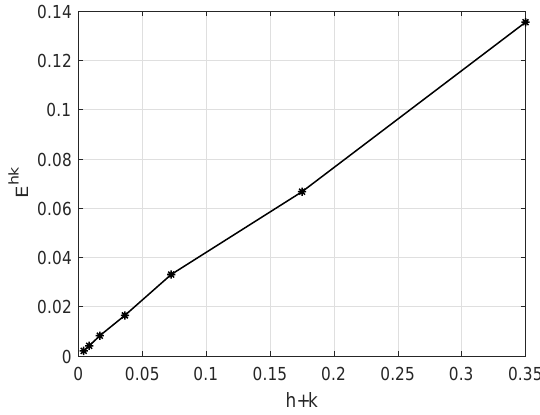
Figure1. Asymptotic constant error. Figure 1. Asymptotic constant